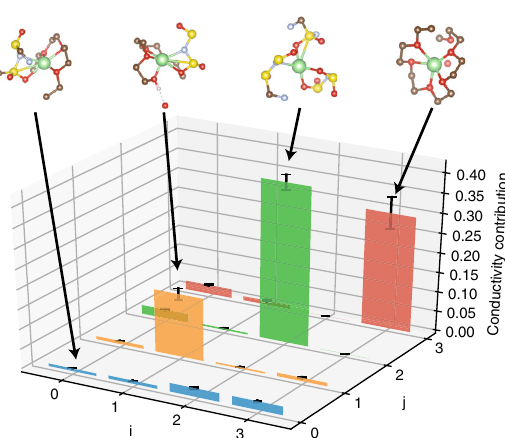
Fig. 5 Contribution from each transition to lithium ion conduction. Each bar denotes the percentage that the transition from state i to state j contributes to the overall lithium ion conduction. The error bars report the 95% con fi dence interval from four independent trajectories in test